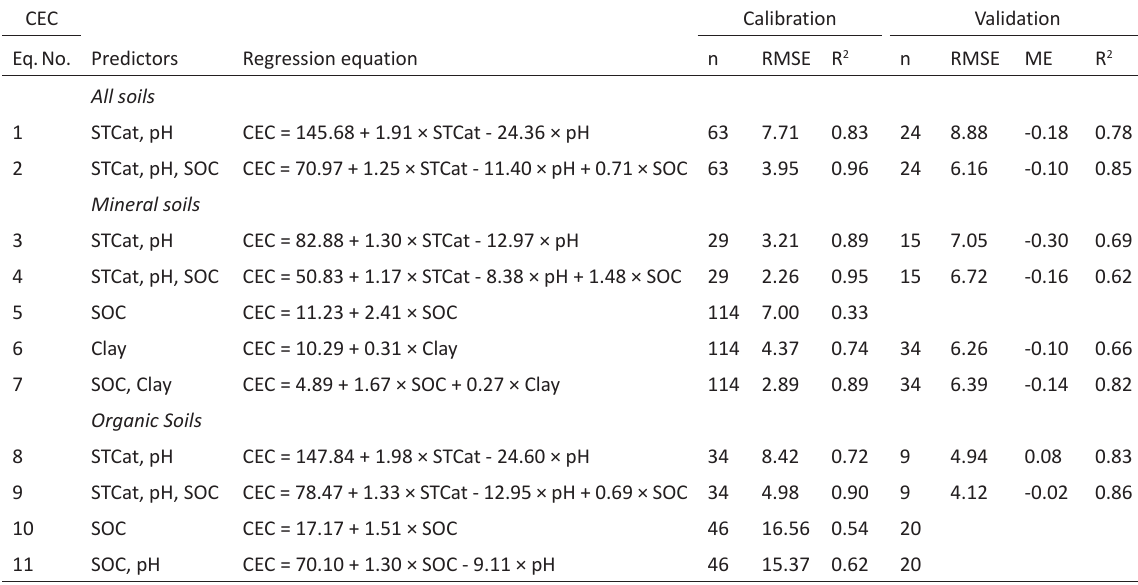
Table 7. Pedotransfer functions for estimating potential cation exchange capacity (CEC, cmol(+) kg -1 ) using sum of soil test cations (STCat cmol(+) l -1 = STCa cmol l -1 × 2 + STMg cmol l -1 × 2 + STK cmol l -1 ), pH and soil organic carbon (SOC, %) as explanatory variables, and statistics of calibration data and validation data CEC Calibration Validation Eq. No.